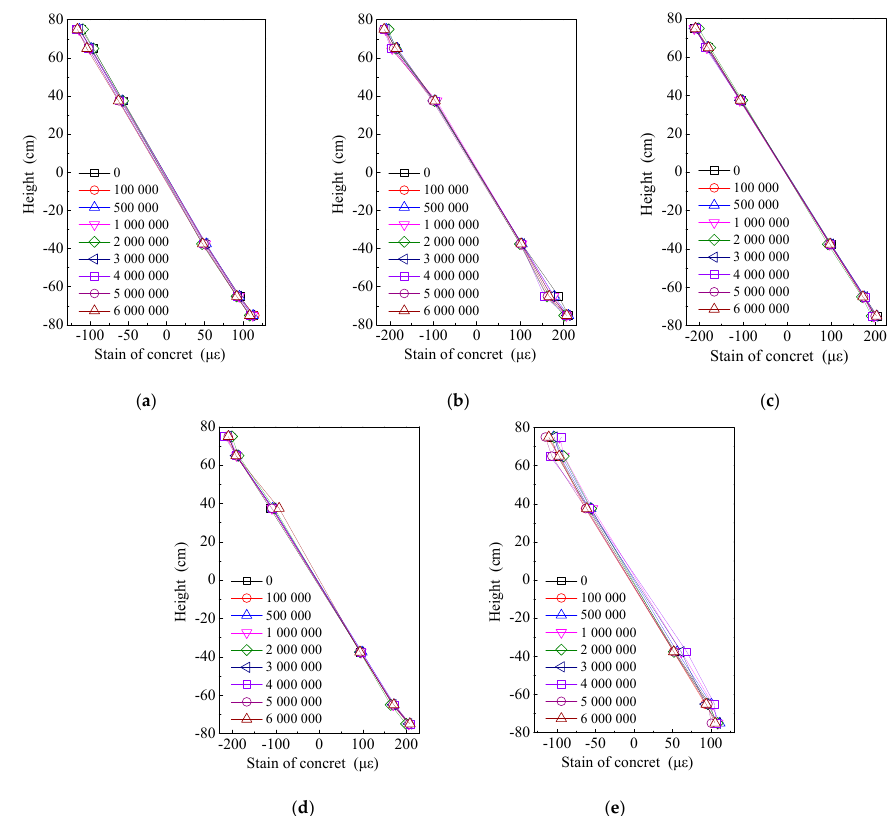
Figure 16. Distribution of concrete strain along height: ( a ) section A-A; ( b ) section B-B; ( c ) section C-C; ( d ) section D-D; ( e ) section E-E.